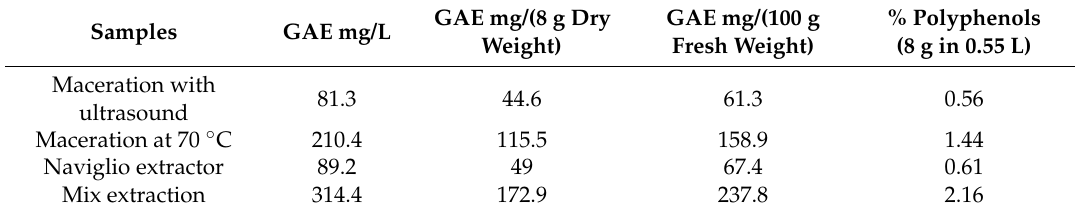
Table 3. Total Polyphenol Content (TPC) of the four types of